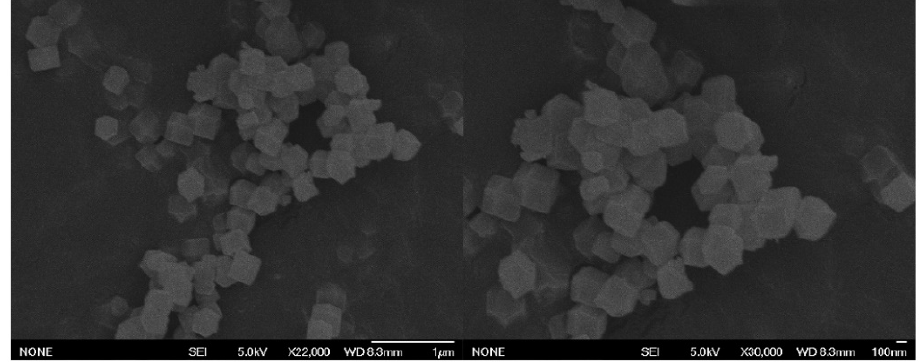
Figure 4. SEM characterization of ZIF-8 .